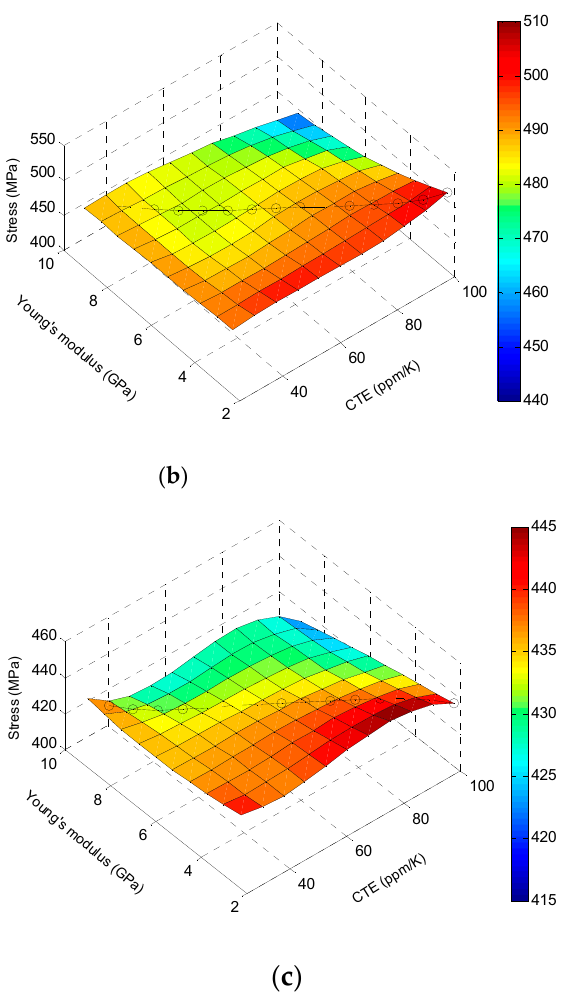
Figure 7. Effect of CTE and Young’s modulus of TSV polymer on TSV stress at three critical locations for Type A. ( a ) Corner #1; ( b ) Corner #2; ( c ) Corner #3.